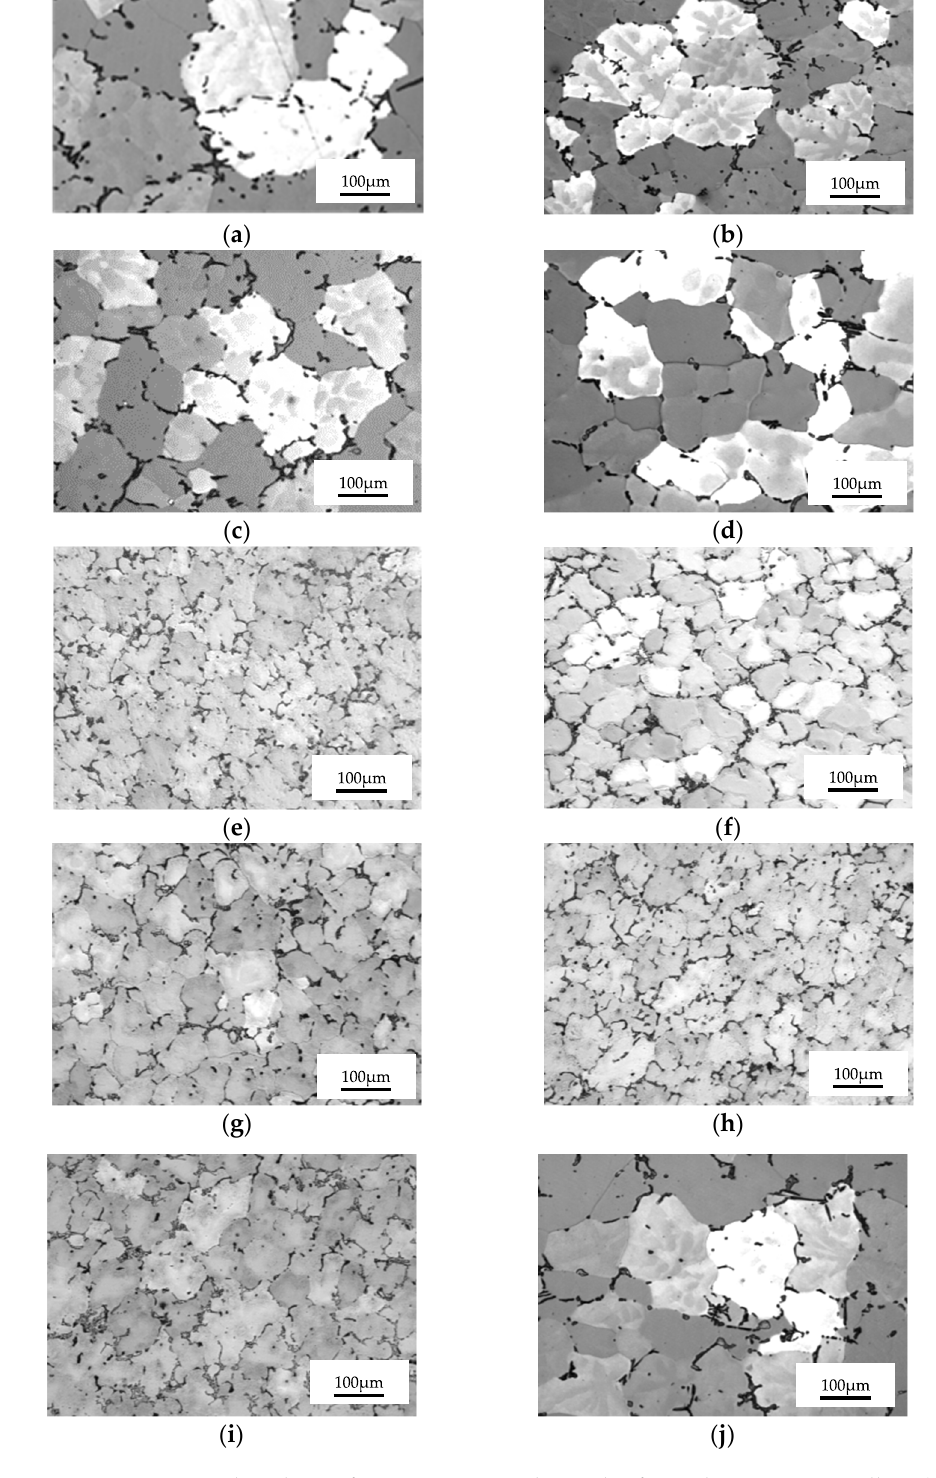
16.83 Figure 7. Evolution of grain size values of the experimental 5083 alloy samples, in different struc- tural state .